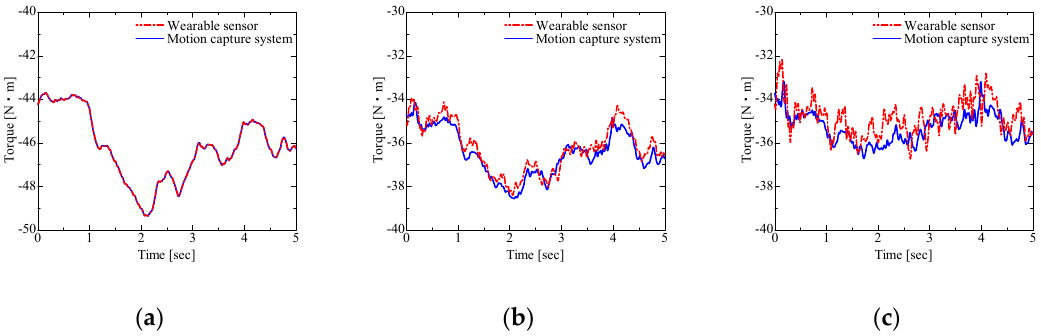
Figure 7. Results for joint torque from the wearable sensor and the motion capture system; ( a ) Ankle joint torque; ( b ) Knee joint torque; ( c ) Hip joint torque